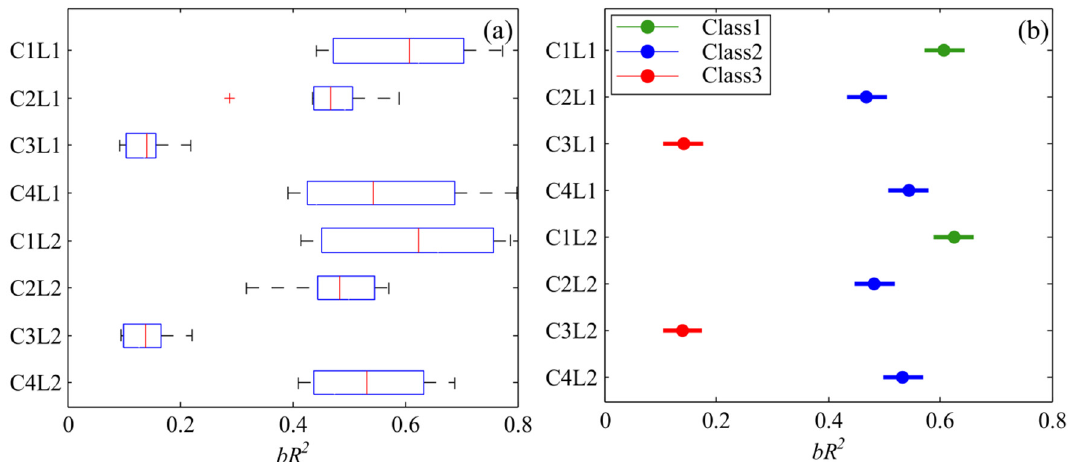
Figure 4. ( a ) The performance of the eight configurations in simulating discharge based on the best simulation after calibration. The red lines show the average bR 2 obtained from the nine outlets, the boxes show the 25th and 75th percentiles and the whiskers show the maximum and minimum. ( b ) The three performance classes obtained by the multiple comparison significance test after calibration. The dots show the average bR 2 values and the ranges indicate the standard error.